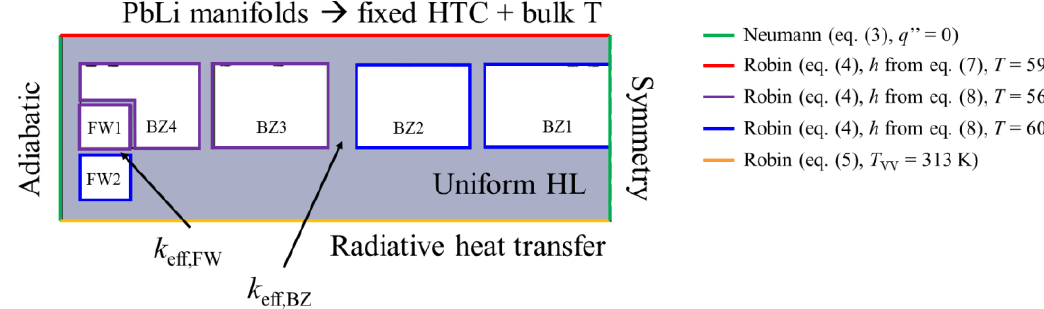
Figure 3. Computational domain and boundary conditions of the 2D finite element (FE) thermal model, highlighting with different colors the different boundary conditions; the nomenclature used in the 2D FE model is also reported. (HL: heat load).